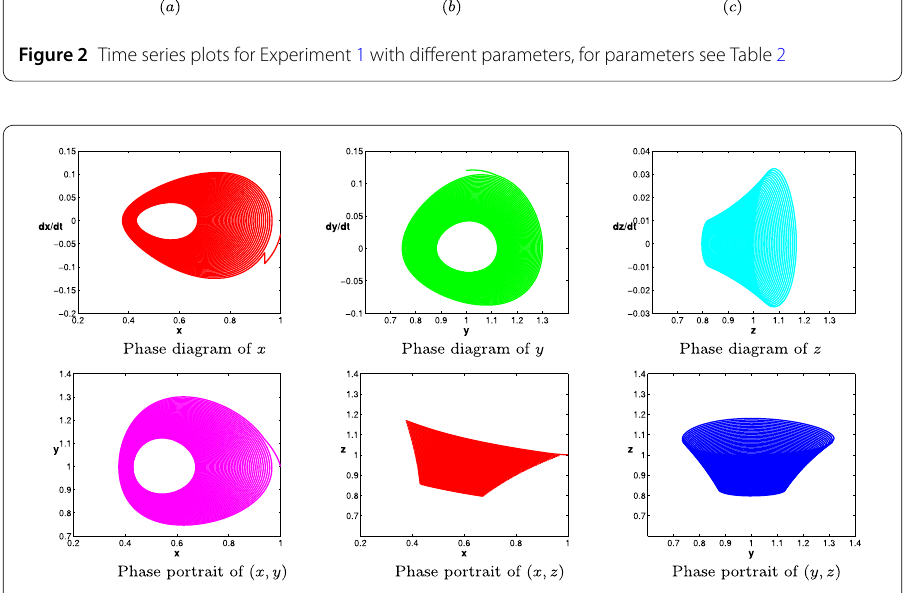
Figure 4 Phase diagram of Experiment 1 with the value of the parameter, for parameters see Table 2